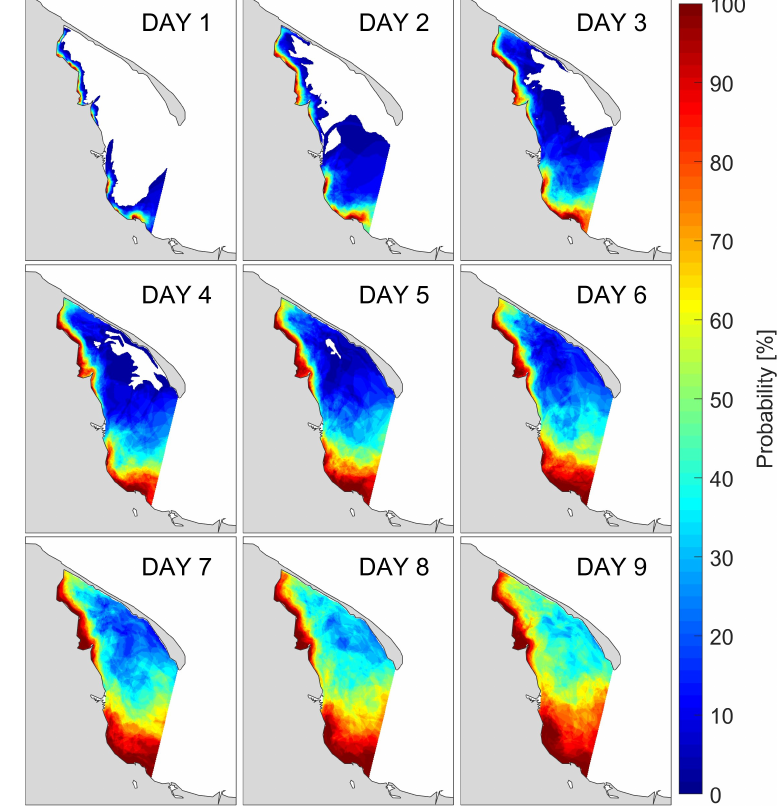
Figure 11. Probability of nutrients reaching location after n = { 1, . . . ,9 }